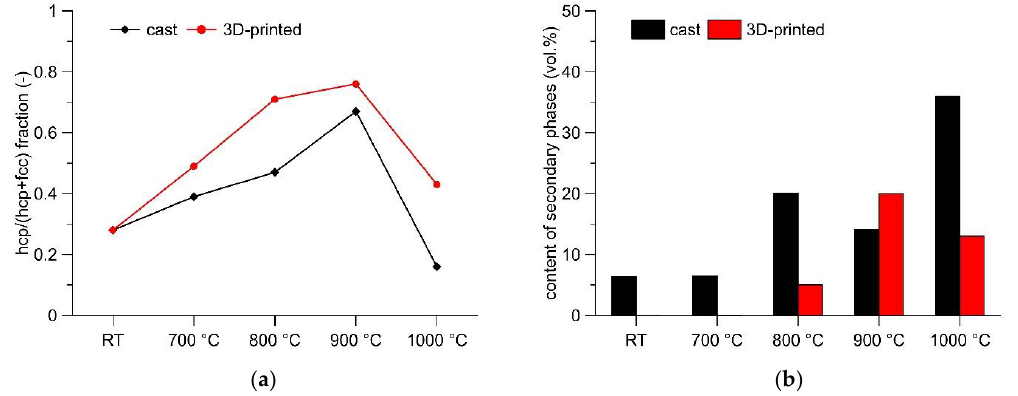
Figure 9. Evolution of phase composition at selected temperatures: ( a ) hcp fraction in the matrix; ( b ) content of secondary phases. Metals 2021 , 11 , x FOR PEER REVIEW